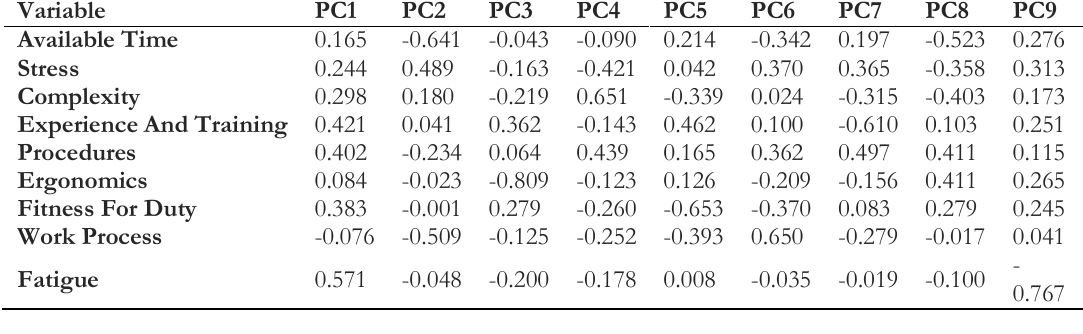
Table 5. Eigenvectors for each PSF.